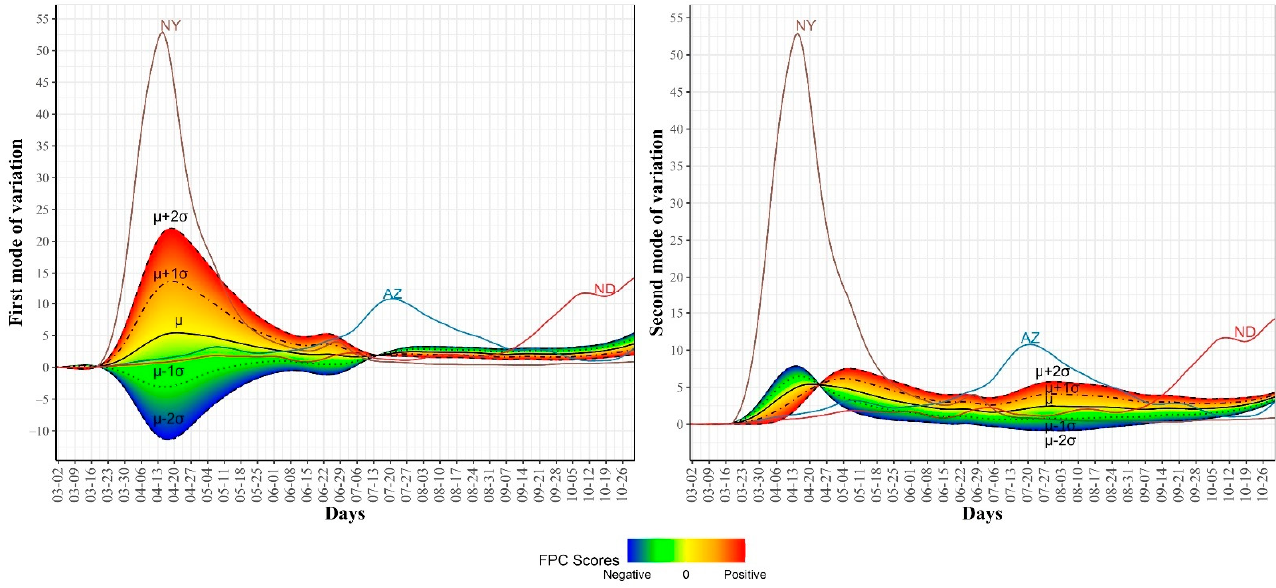
Figure 8. First and second modes of variations for the COVID-19 death trajectories. The sample standard deviations of the first and second FPC scores are 46.57 and 16.99, respectively. The curve for the leading state in each wave is also shown.